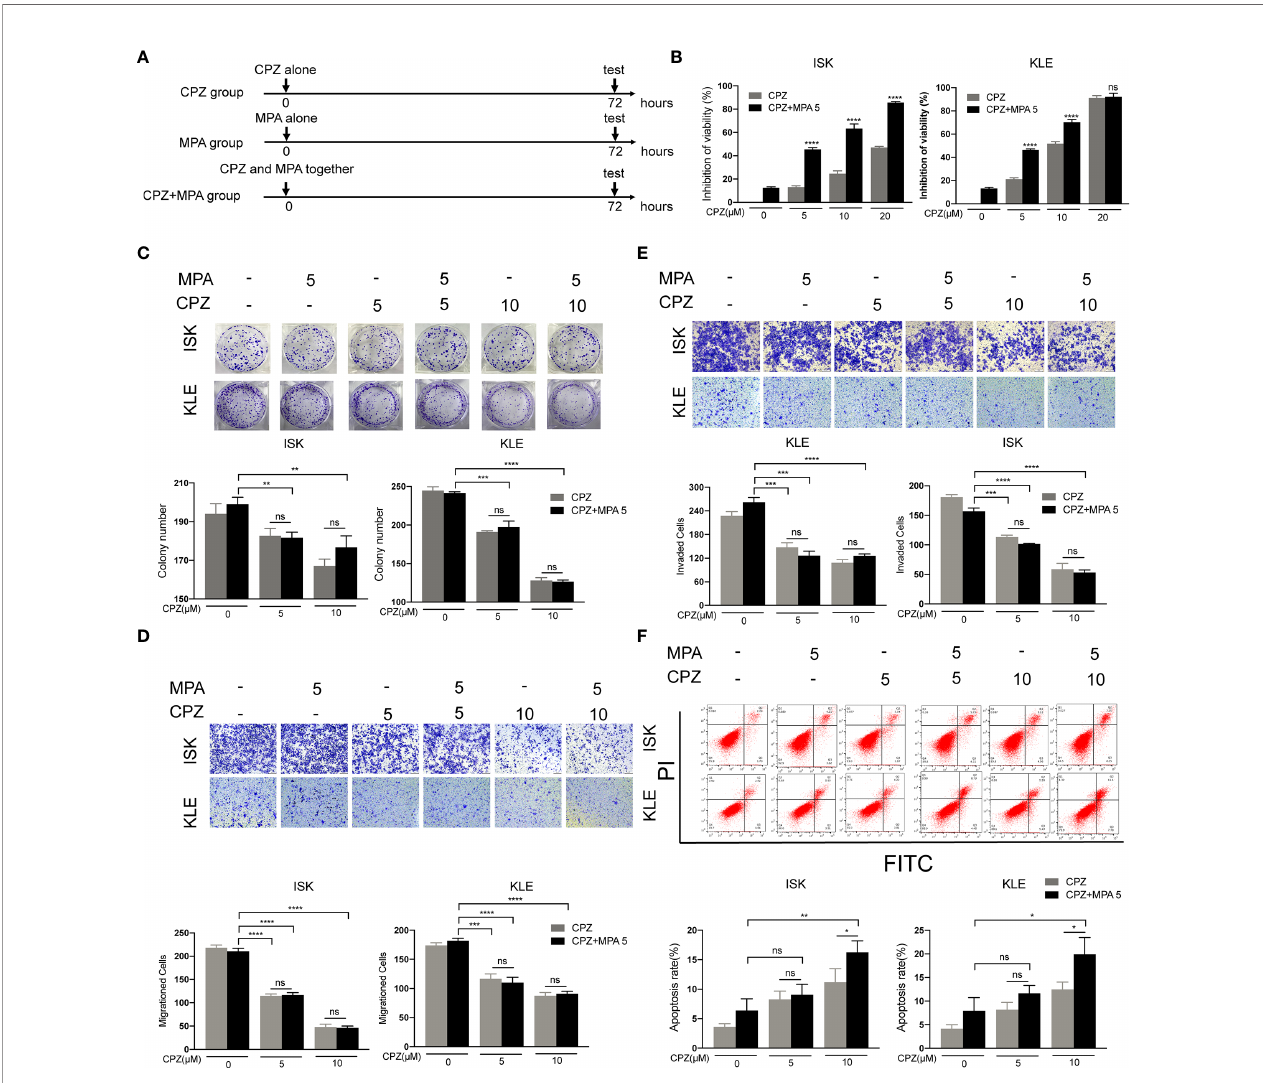
FIGURE 3 | Concomitant treatment induces apoptosis in ISK and KLE cells. (A) Schematic representation of the combination treatment on ISK and KLE cells. Cells were divided into three groups: MPA group (MPA alone), CPZ group (CPZ alone) and MPA + CPZ group (CPZ and MPA together). (B) ISK and KLE cells were exposed to CPZ or MPA as single drugs or in simultaneous combination for 72 h. (C) The colony formation assay was used to evaluate the formation of colonies by ISK and KLE cells when treated with a combination of CPZ and MPA. (D, E) Migratory and invasive ability was assessed in ISK and KLE cells subjected to different treatment regimens. (F) We used fl ow cytometry to determine the rate of apoptosis in ISK and KLE. Results are presented as mean ± standard error of the mean and error bars represent the SD of three independent experiments. ns, not signi fi cant; *p < 0.05; **p < 0.01; ***p < 0.001; ****p <